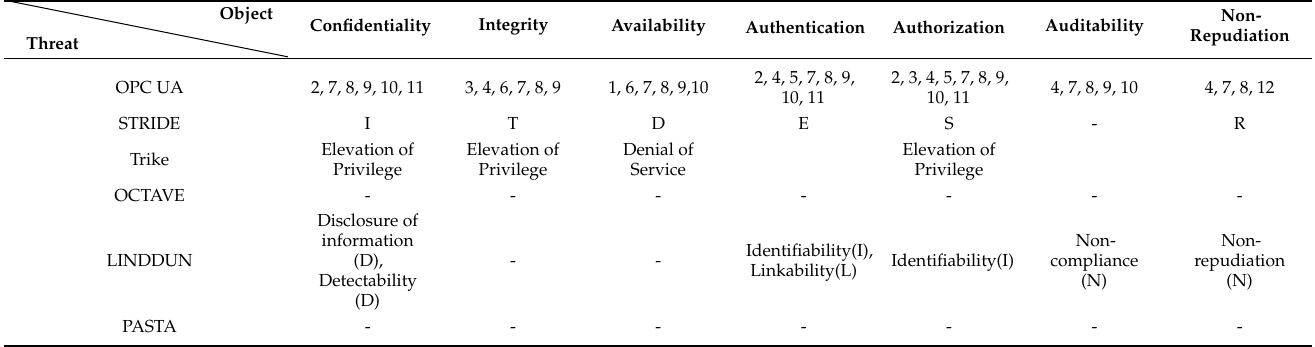
Table 7. Comparison of the scope of OPC UA and threat modeling in response to security